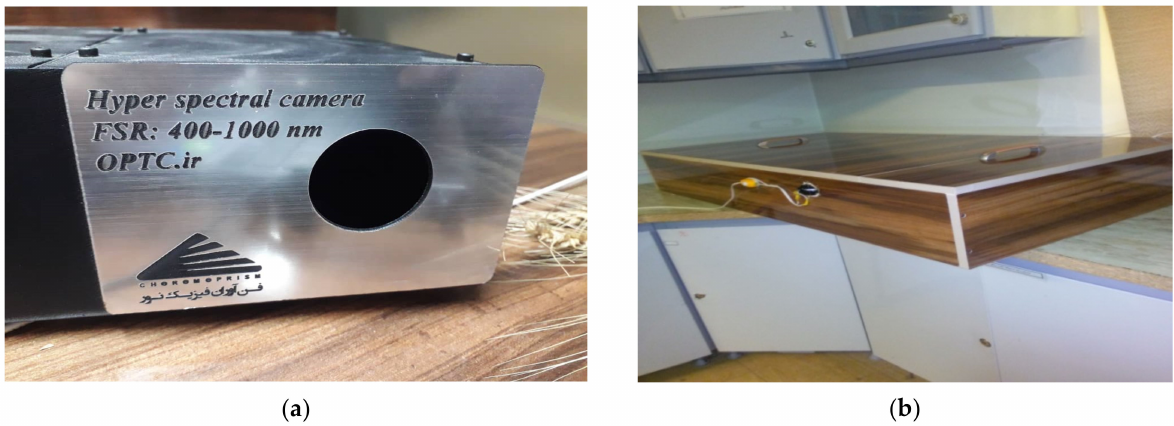
Figure 3. Hardware configuration of the capture system: ( a ) hyperspectral camera; ( b ) illumination